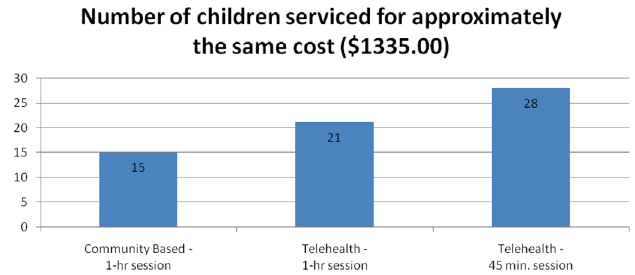
Figure 6 – Number of children serviced for approximately the same cost